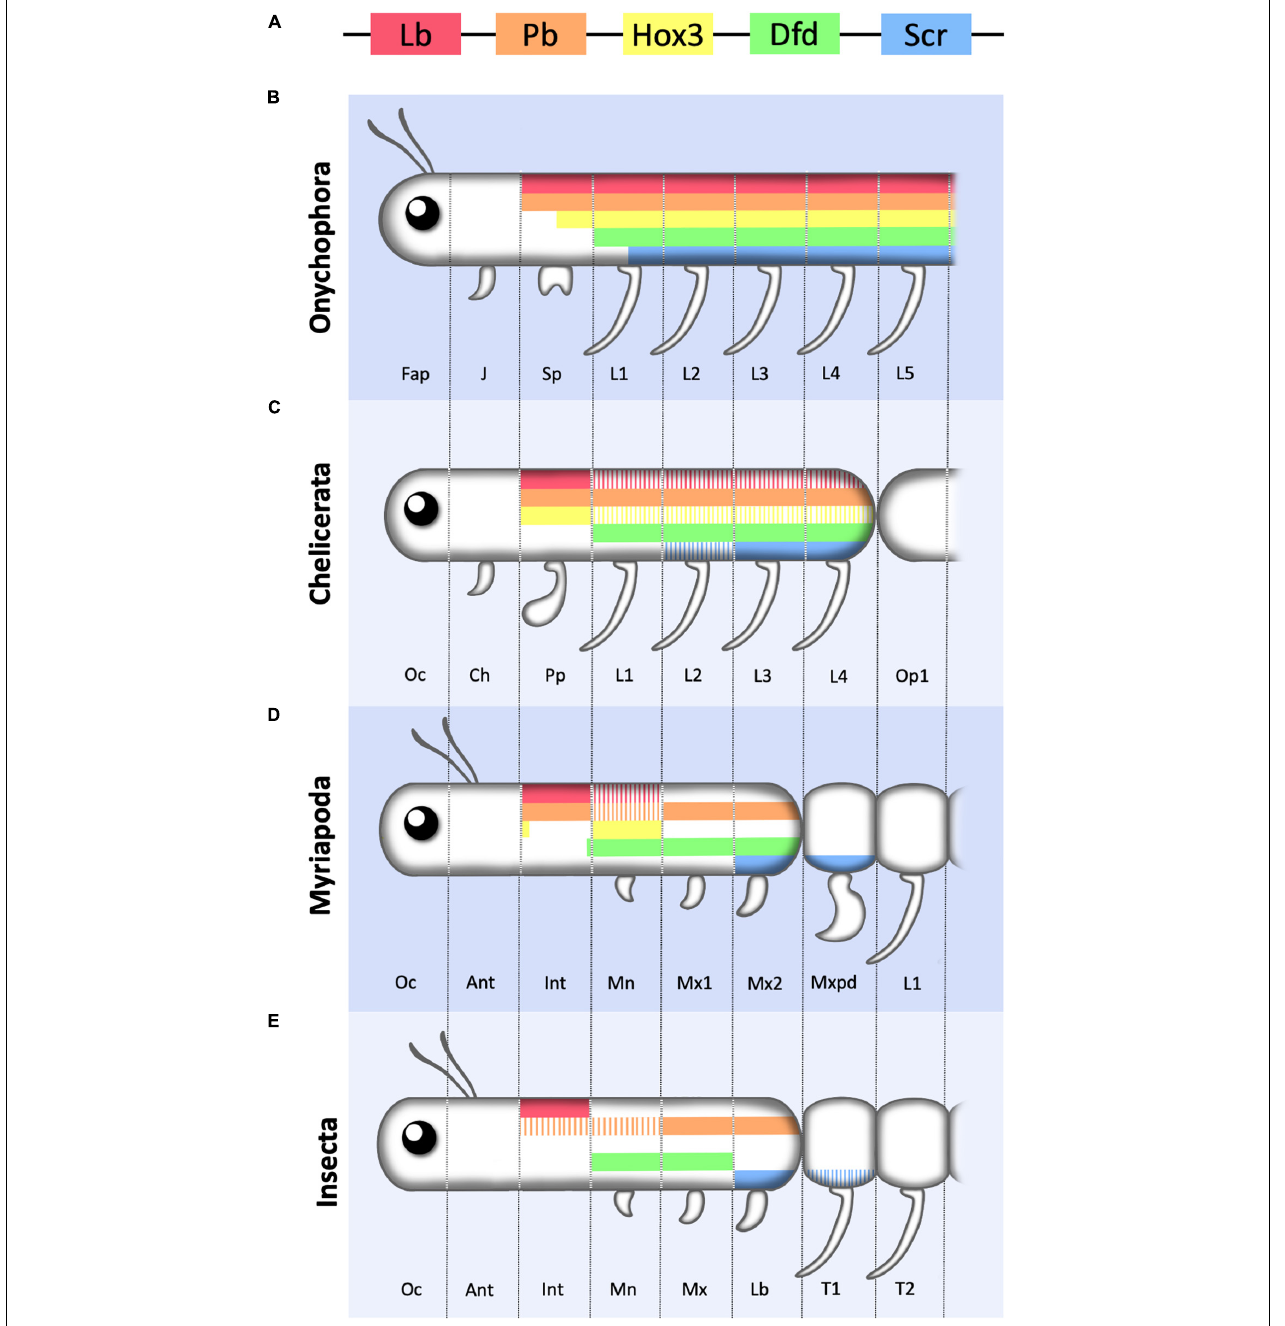
FIGURE 4 | Schematic representation of Hox1–5 expression in the anterior region of the Onychophora and various arthropods. (A) Color key of the five Hox genes considered in this review represented following the relative positions they occupy in the cluster. (B) Onychophora showing the three head segments (Fap, frontal appendage; J, jaw; Sp, slime papilla) and the first five leg (L) bearing segments. (C) Chelicerate showing the first three cephalic segments (Oc, ocular; Ch, chelicerae; Pp, pedipalp) and the four legged prosomal segments. (D) Myriapod showing the six cephalic segments (Oc, ocular; Ant, antennal; Int, intercalary; Mn, Mandibula; Mx1, first maxilla; Mx2, second maxilla) followed by the trunk leg (L) bearing segments of which the most anterior one forms a maxilliped (Mxpd). (E) Insect showing the six cephalic segments (Oc, ocular; Ant, antennal; Int, intercalary; Mn, Mandibula; Mx, maxilla; Lb, Labium) followed by two of the three thoracic leg (L) bearing segments. Hox3 has not been represented as in most insects it has lost its Hox function. Note that the most anterior cephalic segments lack Hox expression, and that anterior Hox genes required for the formation of cephalic structures in insects may be expressed in leg bearing segments in other phyla, indicating that there is no strict correlation between cephalization vs. trunk development and Hox1–5 expression. For simplicity Crustaceans are not included in the figure and coloring represents antero-posterior Hox expression only. Solid bars represent main or stronger expression compared to striped bars. Figure based on data from references (Hughes and Kaufman, 2002b; Janssen et al.,